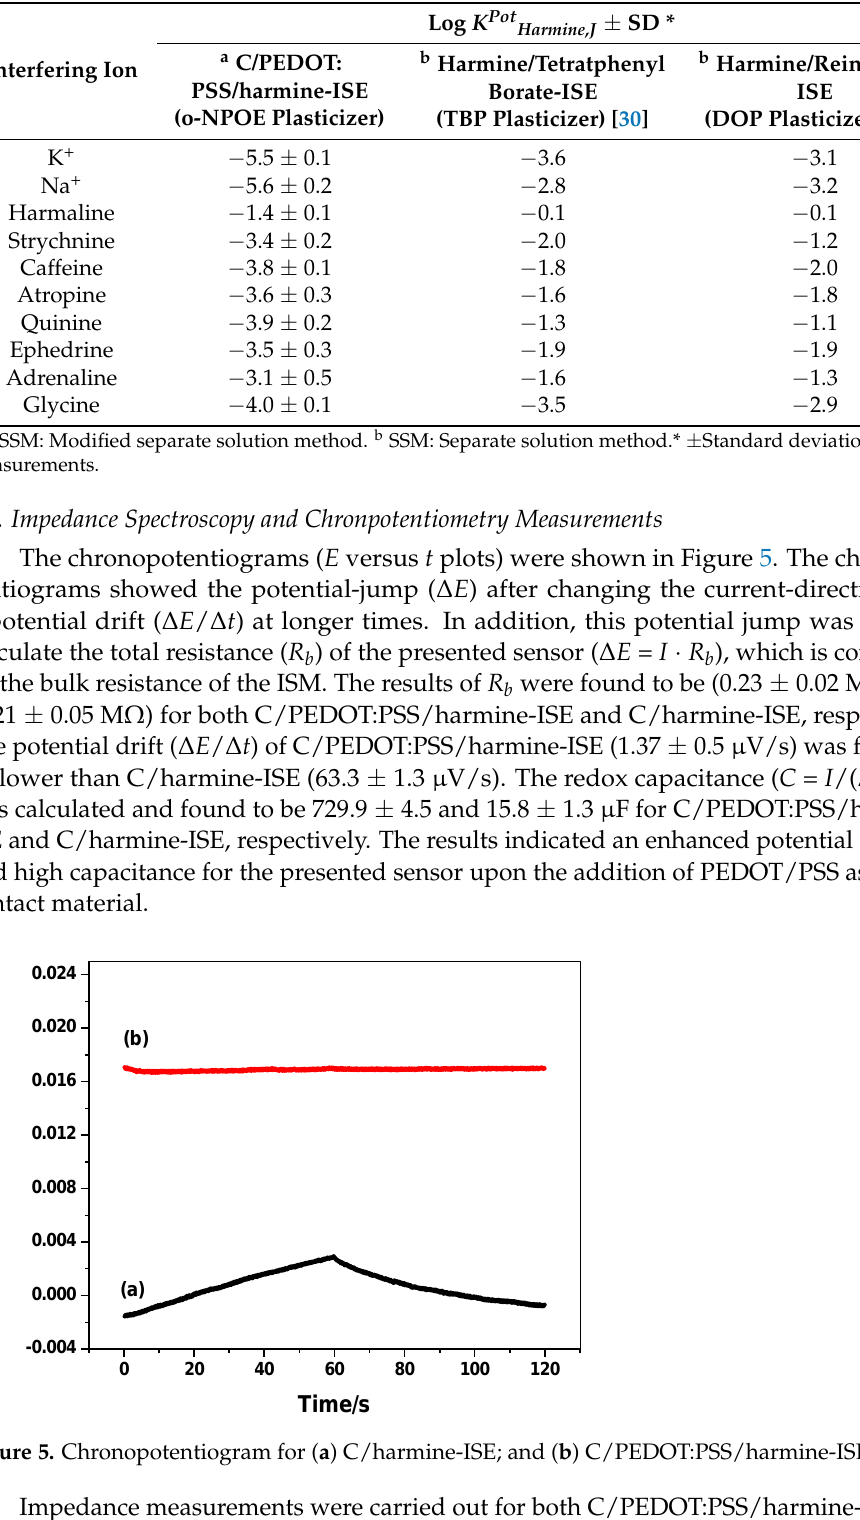
Table 3. The selectivity coefficients (Log K Pot Harmine,J ) of C/PEDOT:PSS/harmine-ISE.